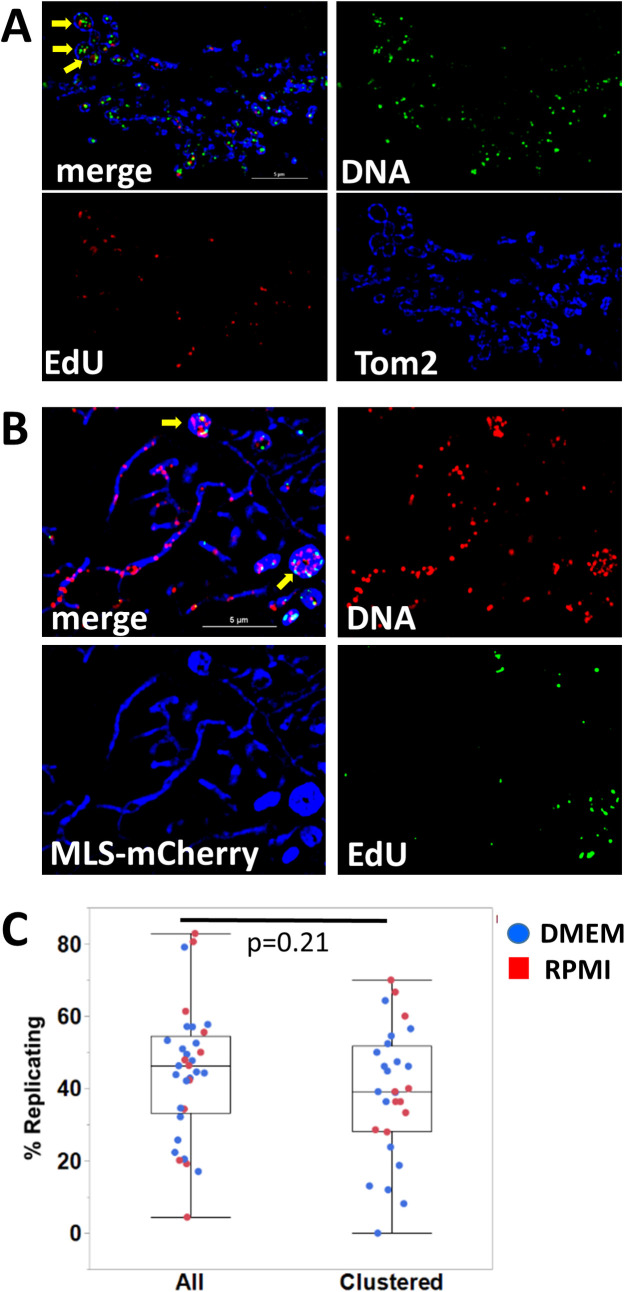
Nucleoids in mito-bulbs are active in mtDNA replication.A. DMEM-adapted A549 cells show positive labeling for EdU foci (red) inside mitochondria at mtDNA nucleoids. Replication is active inside mito-bulb like mitochondria indicated by yellow arrows. Cells were stained with antibodies against DNA (green) and Tom20 (blue). Resolved channels are displayed as separate panels as indicated. Scale bar in A is 5 μm. B. RPMI-adapted A549 cells expressing MLS-mCherry (blue) were labeled with EdU detected using click chemistry (green) and stained with anti-DNA antibodies (red). Arrows indicate EdU incorporation at nucleoids in bloated mitochondria. Scale bar is 5 μm. C. Box-and-whisker plot of the percentage of nucleoids that incorporated EdU in the total population of nucleoids and in the subset of nucleoids clustered in bloated mitochondria. Data for 33 specimens in 4 independent experiments are compiled in Table 2. Boxes indicate means and quantile values for the distributions, which were not significantly different (p = 0.21).